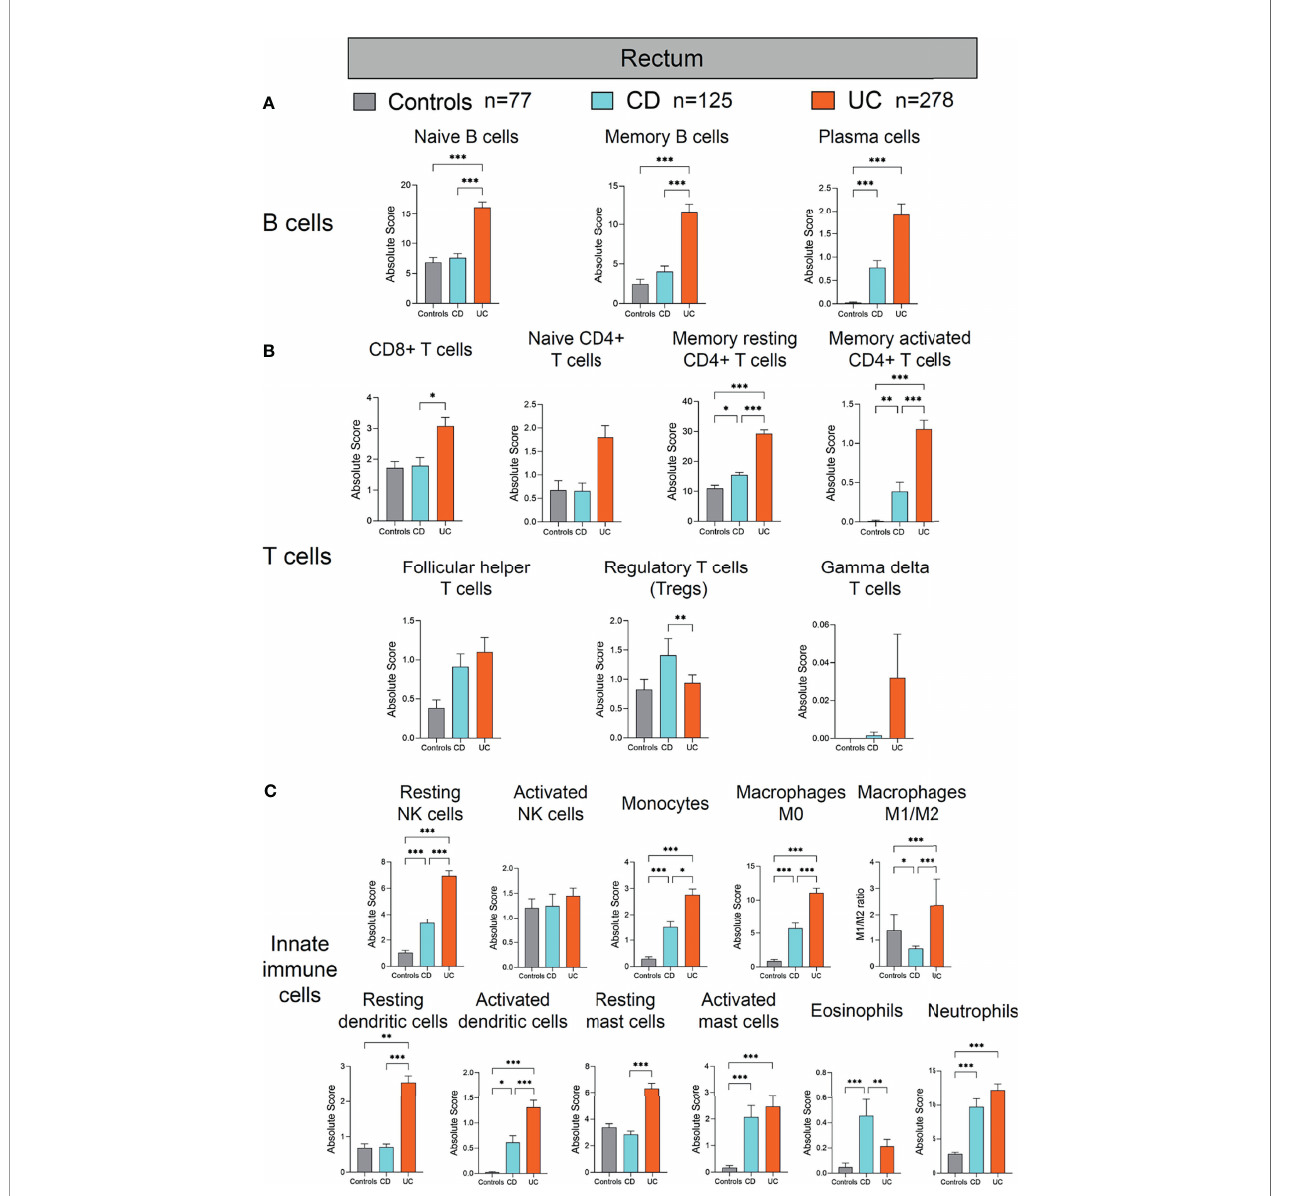
FIGURE 6 | Absolute quantity of immune cells pro fi ling in the rectum of patients with IBD and healthy individuals. (A) Comparisons of the B-cell subpopulations among three disease subtypes in the rectum. (B) Comparisons of the T-cell subpopulations among three disease subtypes in the rectum. (C) Comparisons of the innate immune cell subpopulations among three disease subtypes in the rectum. Statistical signi fi cance was determined by Kruskal – Wallis non-parametric test and Dunn ’ s multiple comparisons test. * p < 0.05, ** p < 0.01, *** p <